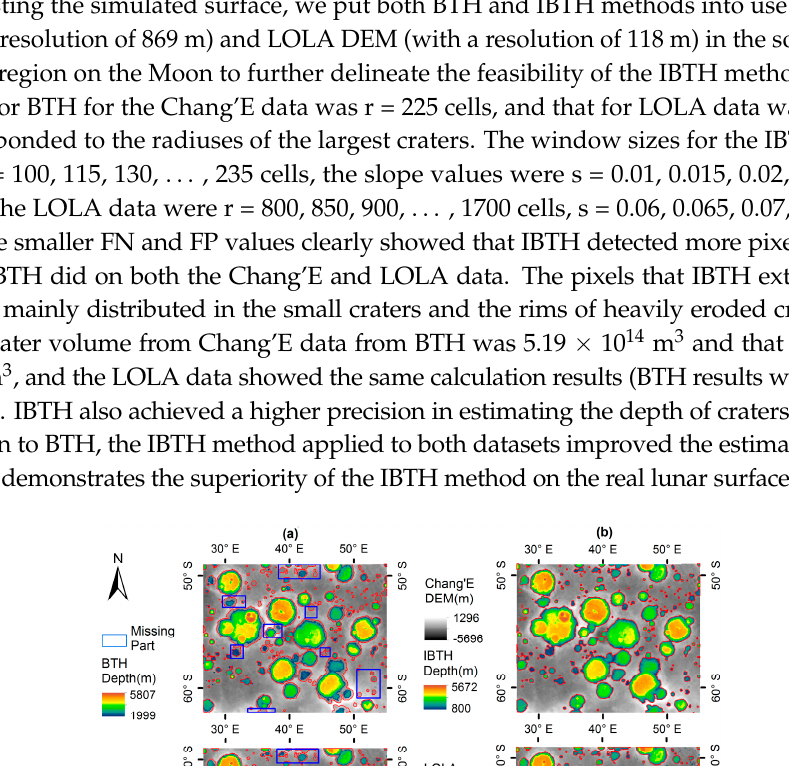
Figure 5. The iterative calculating process of IBTH with the changeable window size and slope value. Different color lines with points represent the volume change under different window sizes with a certain slope factor. The purple line is the true volume of all craters on the simulated surface and the orange line is the IBTH volume of simulated craters.